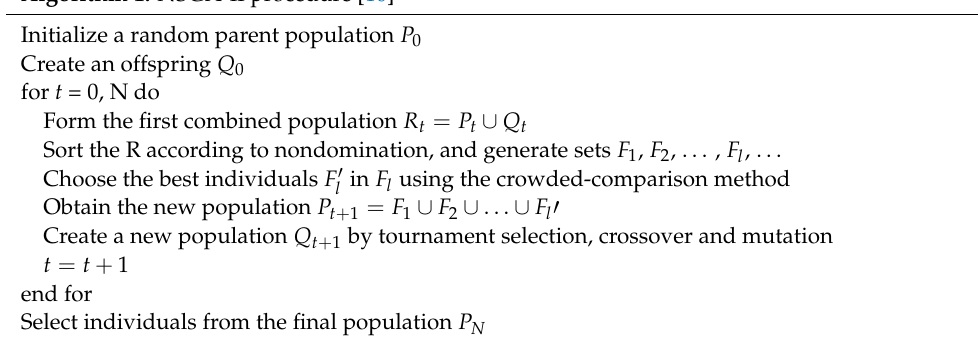
Algorithm 1: NSGA-II procedure